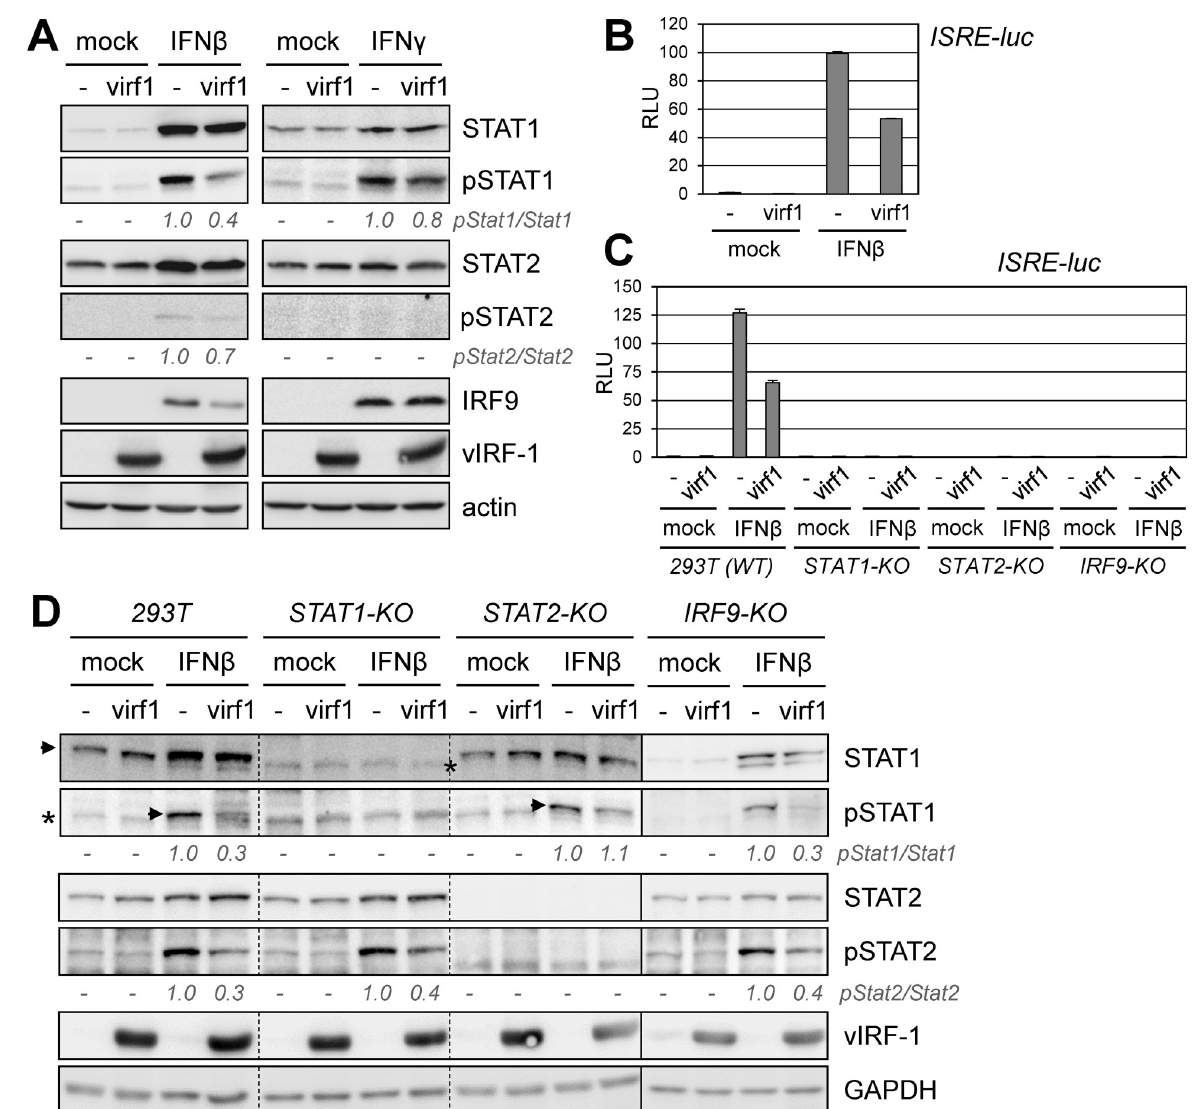
Fig 3. Regulation of IFN β signaling by vIRF-1 in transfected cells. (A) 293T cells transfected with empty vector (-) or vIRF-1 expression plasmid (virf1) were left untreated or treated with IFN β or IFN γ (50 ng/ml of each) for 24 h. Cells were then harvested and lysates analyzed by immunoblotting for relative levels of pSTAT1 and pSTAT2, total STAT1 and STAT2, and IRF9. As applicable (detected), pSTAT1/STAT1 and pSTAT2/STAT2 ratios (“empty vector” values set at 1) are shown below the respective blots for IFN β - and IFN γ -treated cells. (B) vIRF-1 suppression of IFN β -induced signaling, as measured by ISRE-luciferase (luc) reporter assay, was detected in 293T cells cotransfected with the reporter and empty vector (-) or expression plasmid for vIRF-1 (virf1), left untreated or treated with IFN β (50 ng/ml) for 24 h. Relative luciferase assay-derived luminescence values (RLU, means from duplicate transfectants) are shown along with standard deviations from the means. Student’s t-test P value (unpaired, two-tailed) for vIRF-1 suppression of IFN β signaling (vIRF-1-vector relative to empty-vector RLU) is 0.0005. (C) STAT1, STAT2, and IRF9 knockout (KO) 293T cell lines were generated by Cas9/gRNA transduction, blasticidin selection, and clonal isolation of cells (see Materials and Methods). Target-gene ablation in each of the cell lines was tested functionally by ISRE-luciferase reporter assay following IFN β stimulation (chart; N = 2). Mock, untreated cultures; virf1, vIRF-1 vector-transfected cells; -, empty vector-transfected cells. (D) vIRF-1 suppression of IFN β -activated STAT1 and STAT2 (pSTAT1, pSTAT2) as a function of STAT1, STAT2, and IRF9 knockout. Cultures were transfected with empty vector (-) or vIRF-1 expression plasmid (virf1) and, after 6 h, treated with IFN β (50 μ g/ml) for 24 h. Cell lysates were analyzed by immunoblotting; numbers below the pSTAT1 and pSTAT2 blots show quantified pSTAT1 and pSTAT2 levels normalized to total STAT1 and STAT2, respectively, in the absence (value set at 1) and presence of vIRF-1. Arrows, STAT1/pSTAT1; asterisks, non-specific bands; dotted lines, lane deletions from single blot; solid line, different membrane.